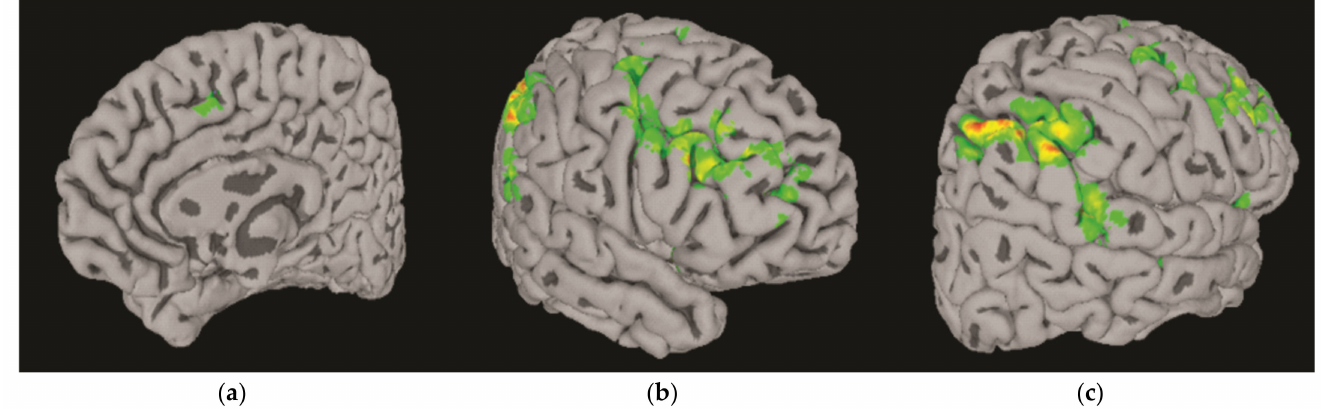
Figure 4. Right hemispheric cortical regions where positive BOLD response in the AUD group was signif-icantly lower relative to in the control group: ( a ) medially presupplementary motor area, ( b ) bi-lateral anterior insula, inferior and middle frontal cortices, and ( c ) posteriorly superior parietal lobule, angular gyri, and middle temporal